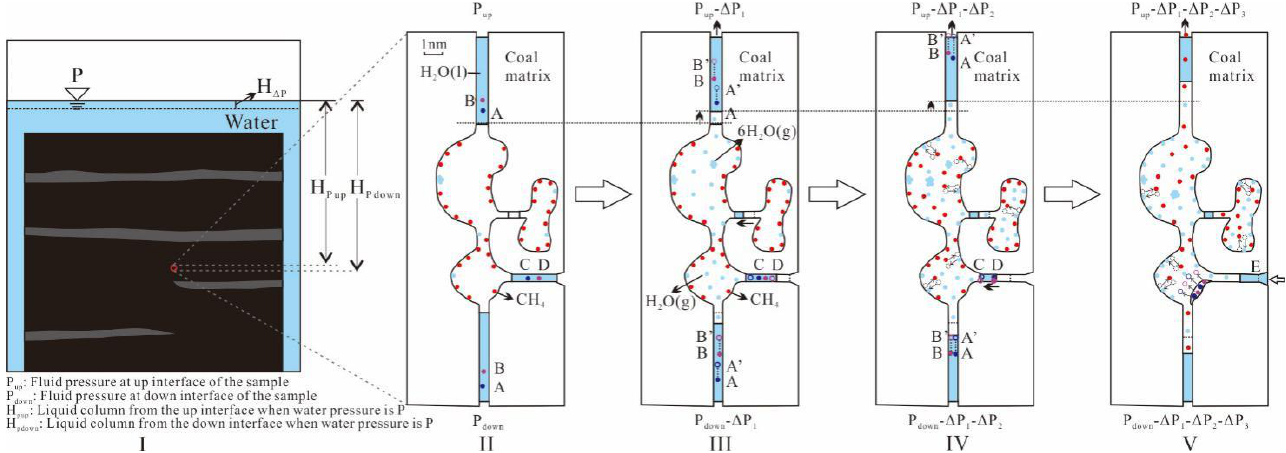
Figure 21. Desorption mechanism of CH 4 in durain (interconnected pores) covered with water. I: The coal reservoir covered with water; II: Initial state; III: a Free CH 4 enters the top of the vacuum vessel, and discharges under negative pressure; IV: Water spreads out on the pore surface; V: Capillary pore throats are refilled with water.